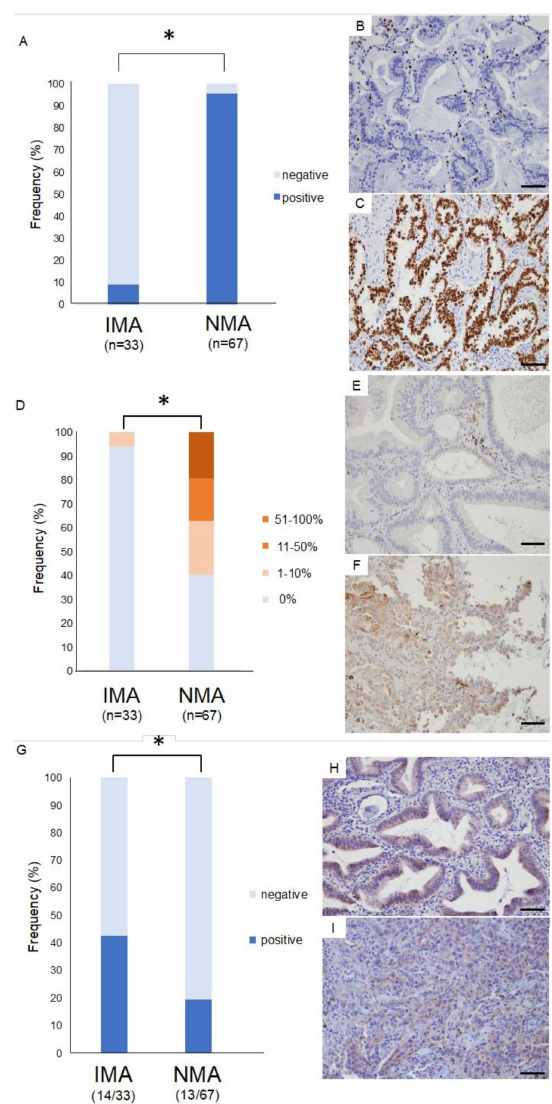
Figure 3. Immunostaining for thyroid transcription factor 1 (TTF-1) and immune checkpoint proteins in invasive mucinous adenocarcinoma (IMA) and nonmucinous adenocarcinoma (NMA). ( A ) TTF-1 was detected in nearly all patients with NMA, but in only a few patients with IMA. *, p < 0.05. ( B , C ) Representative TTF-1 immunostaining in IMA ( B ) and NMA ( C ). ( D ) Programmed death ligand 1 (PD-L1) was detected in 59.7% patients with nonmucinous adenocarcinoma, but in only 6.1% of patients with invasive mucinous adenocarcinoma, a statistically significant difference in frequency. *, p < 0.05. ( E , F ) Representative PD-L1 immunostaining in IMA ( E ) and NMA ( F ). ( G ) B7-H3 was detected in 19.4% patients with NMA and in 42.4% of patients with IMA, a statistically significant difference in frequency. *, p < 0.05. ( H , I ) Representative B7-H3 immunostaining in IMA ( H ) and NMA ( I ). Scale bars: 100 µ